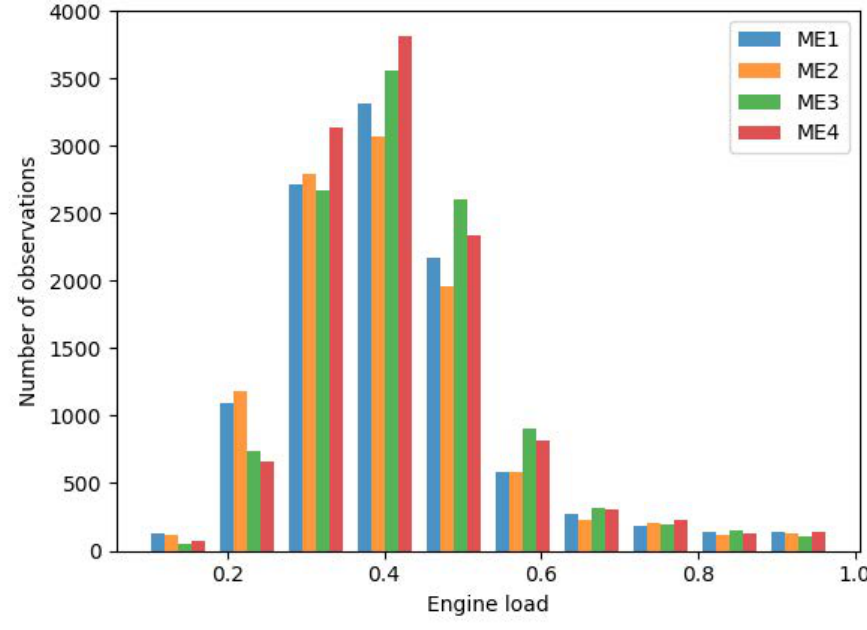
Figure 9. Yearly load distribution of the ship’s main